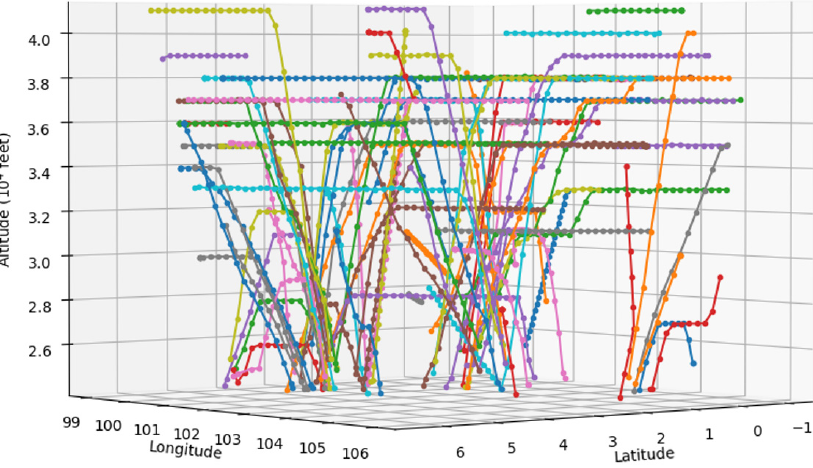
Figure 6. Visualization of flight trajectory from 11:00 UTC to 12:00 UTC on 1 December 2019.